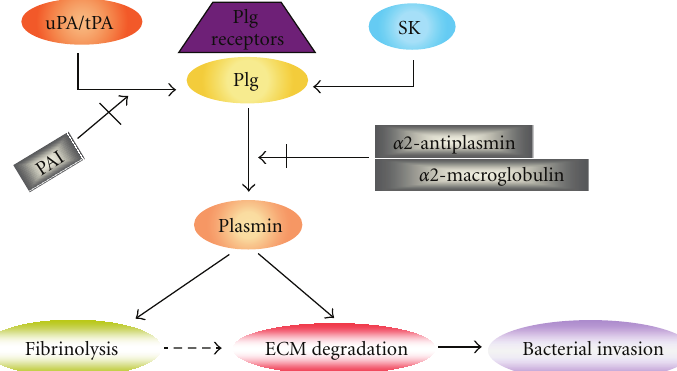
Figure 1: Simplified overview of the mammalian plasminogen system and its utilization by bacteria. Bacterial plasminogen receptors immobilize plasminogen on the surface, which enhances activation of plasminogen to the active serine protease, plasmin, by host plasminogen activators uPA, tPA and/or bacterial plasminogen activators like streptokinase (SK). Both tPA and uPA can be inhibited by plasminogen activator inhibitors (PAI), while plasmin activity is controlled by its major inhibitor, α 2-antiplasmin, and to a lesser extent by α 2-macroglobulin. Plasmin degrades fibrin clot (fibrinolysis) and various ECM components which enables bacterial migration through tissue barriers.